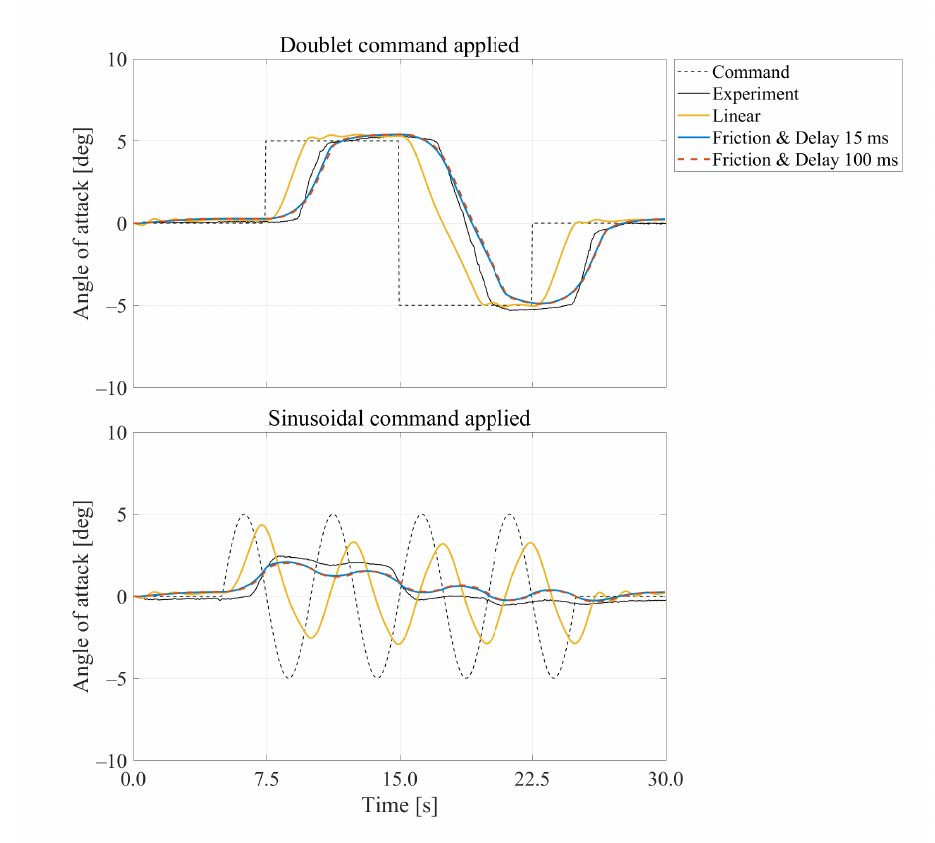
Figure 9. Simulated pitch control results for NN10 with doublet ( top ) and sinusoidal ( bottom ) commands at wind speed of 10